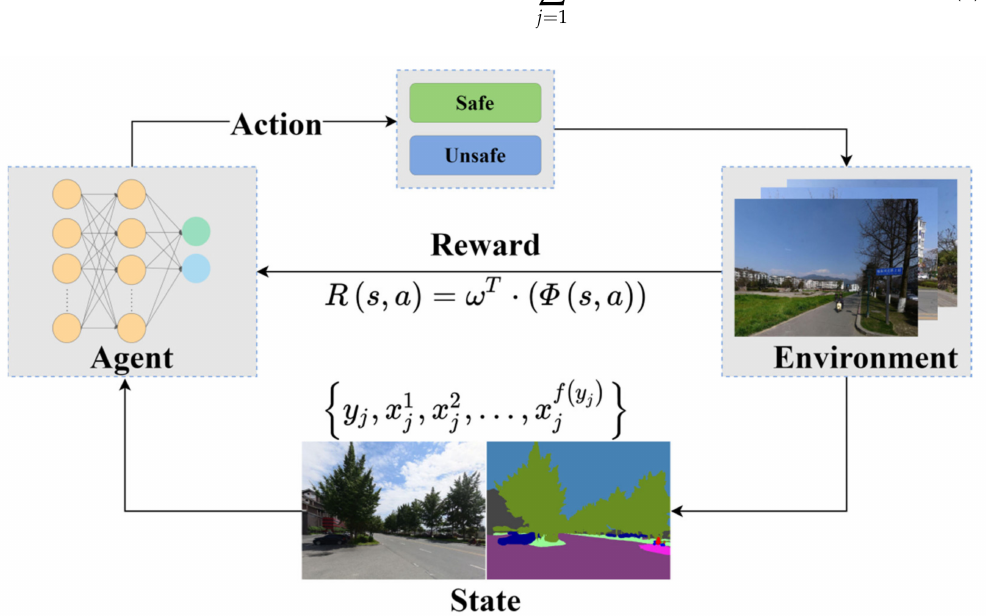
Figure 5. The Markov decision process of our framework. The neural network agent ( left ) learns to exploit the visual state ( bottom ) to predict the action, which is the perceived safety indicator ( top ). Then, the agent explores the environment ( right ) to maximise the total reward ( middle